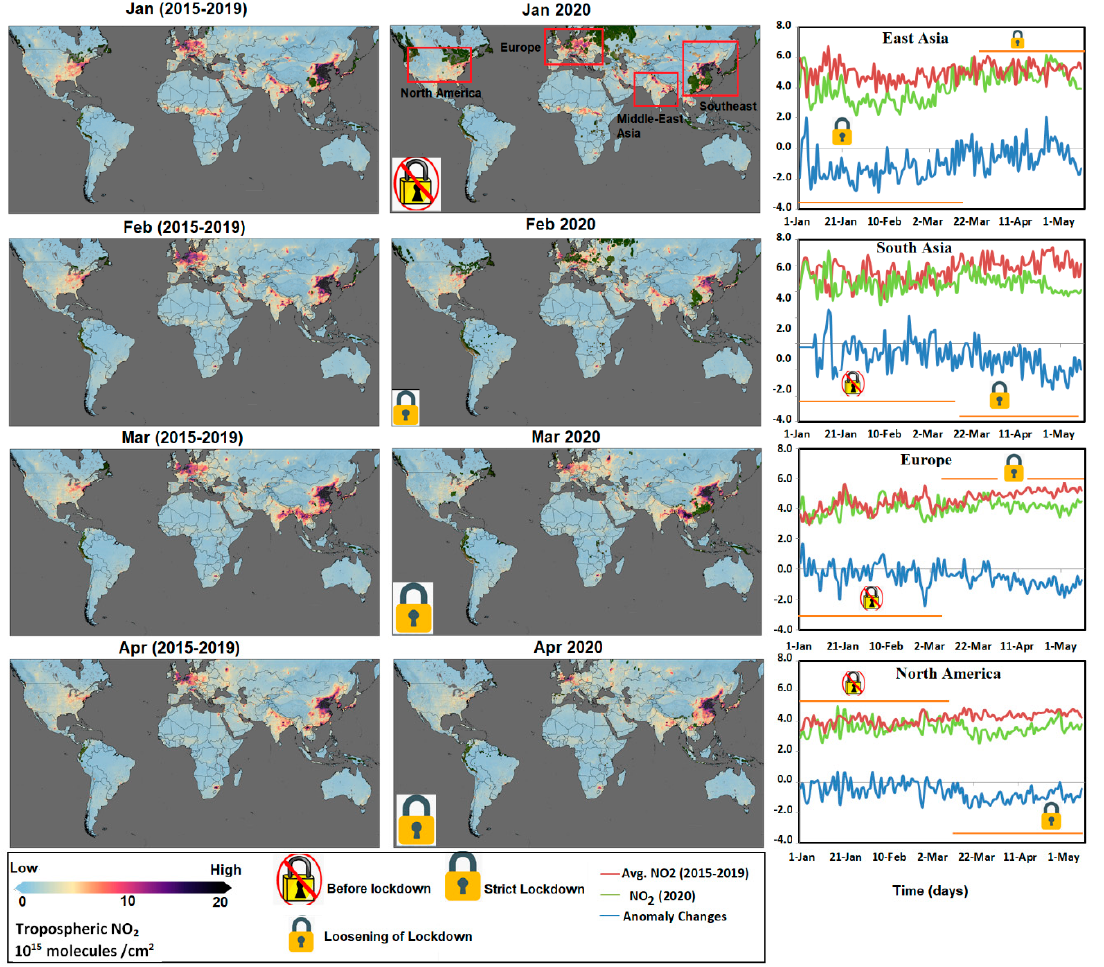
Figure 3. Spatial and temporal variations of NO 2 before and after the lockdown in 2020 compared with the baseline (2015–2019 averaged data). The left two columns represent the spatial views and the right column represents the time series